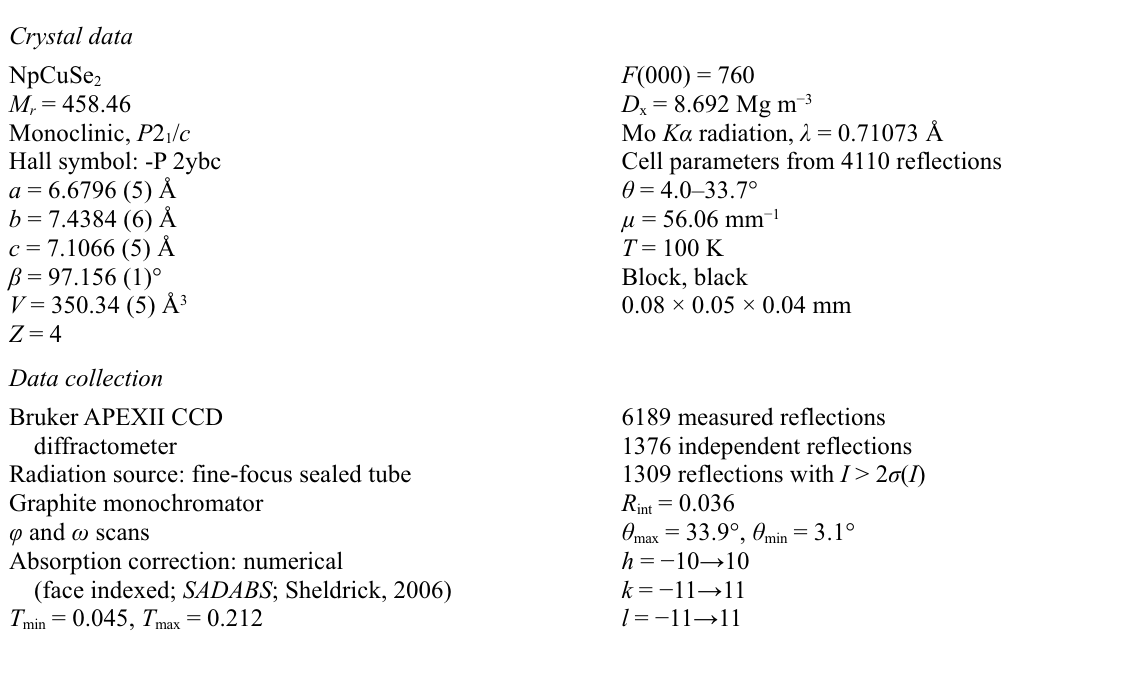
A view nearly down [010] of the unit cell of NpCuSe2, with displacement ellipsoids at the 99% probability level. Neptunium(III) copper(I)